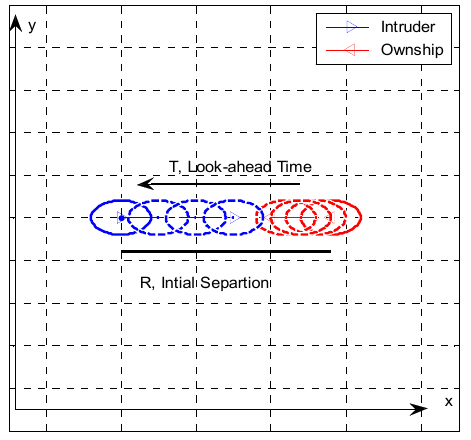
Figure 5. Head-to-head encounter in 2-D plane. Figure 5 . Head-to-head encounter in 2-D plane.